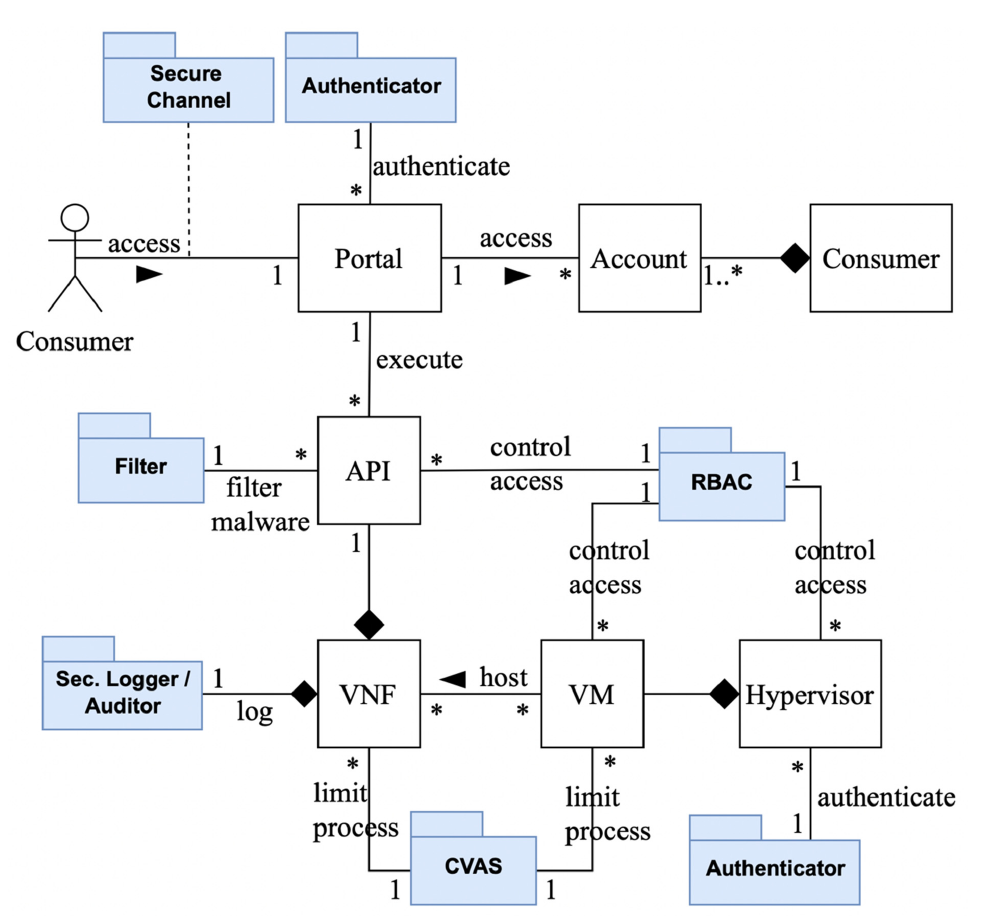
Figure 7. An extended version of the NFV SRA.